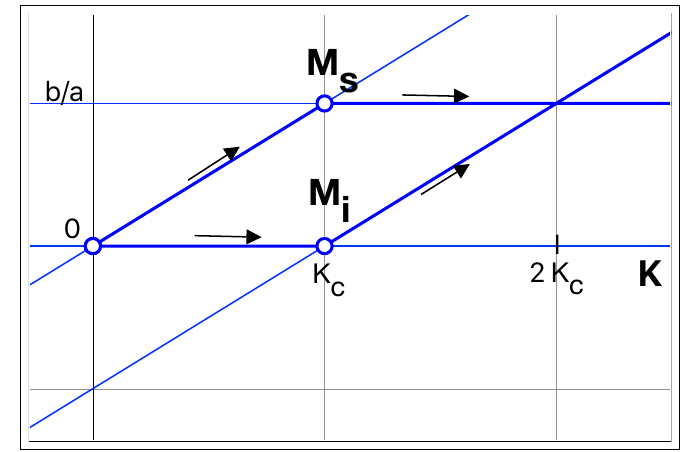
Figure 2. Steady-state values of susceptible mice ( M s ) and infected mice ( M i ) as a function of the carrying capacity K . Note the transcritical bifurcation at K = K c . The infected mice stationary solution switches from 0 to a linear increase with K , while the number of susceptible mice switches from a linear growth with K to become constant. Therefore, after the bifurcation, the increase in the carrying capacity has, as a consequence, an increase of infected mice. The arrows in the figure show the evolution of both populations as K is increased.